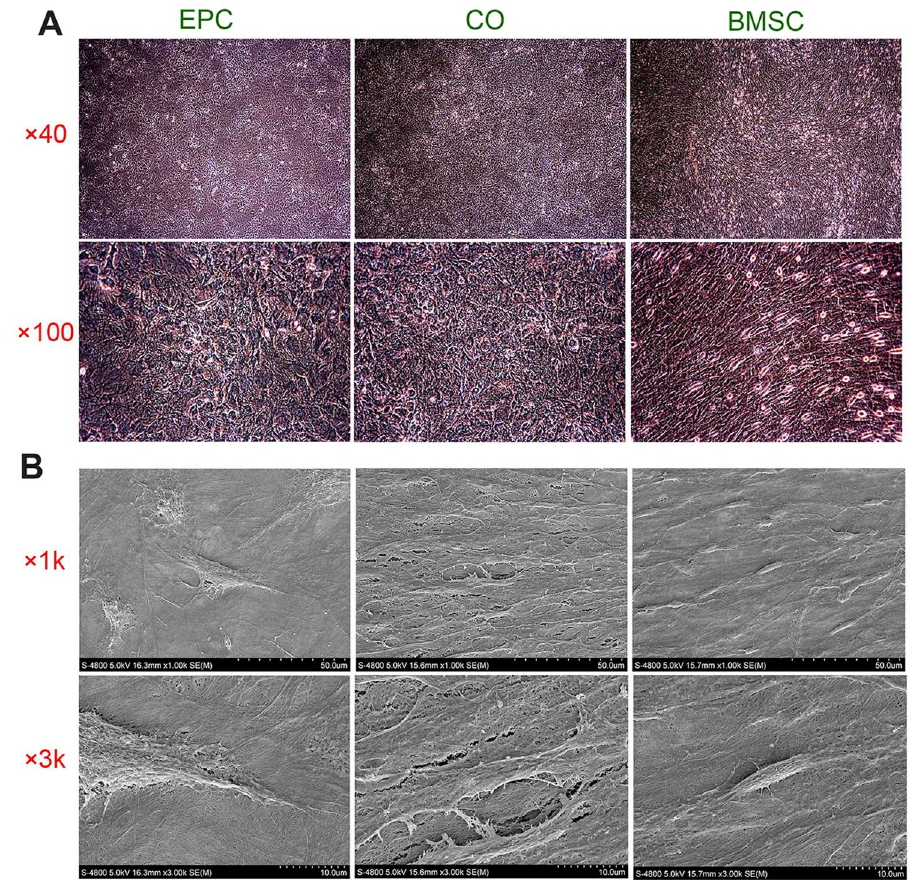
Figure 2. Morphology of cell sheet. ( A ) Representative microscopic view of cell sheet morphology after 8 days of induction. ( B ) Representative SEM images of the cell sheets attached to Ti